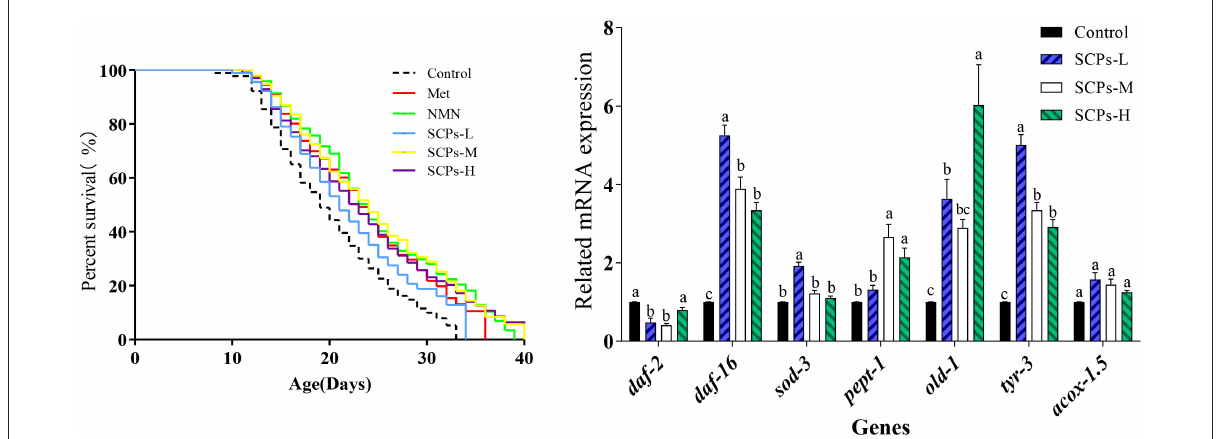
FIGURE2 Effects of SCPs on the lifespan of wild-type C. elegans under normal conditions. Statistical analyses were carried out using GraphPad software. A Kaplan-Meier lifespan analysis was carried out, and p-values were calculated using the log-rank test. In all statistical analyses, p < 0.05 was accepted as statistically significant.